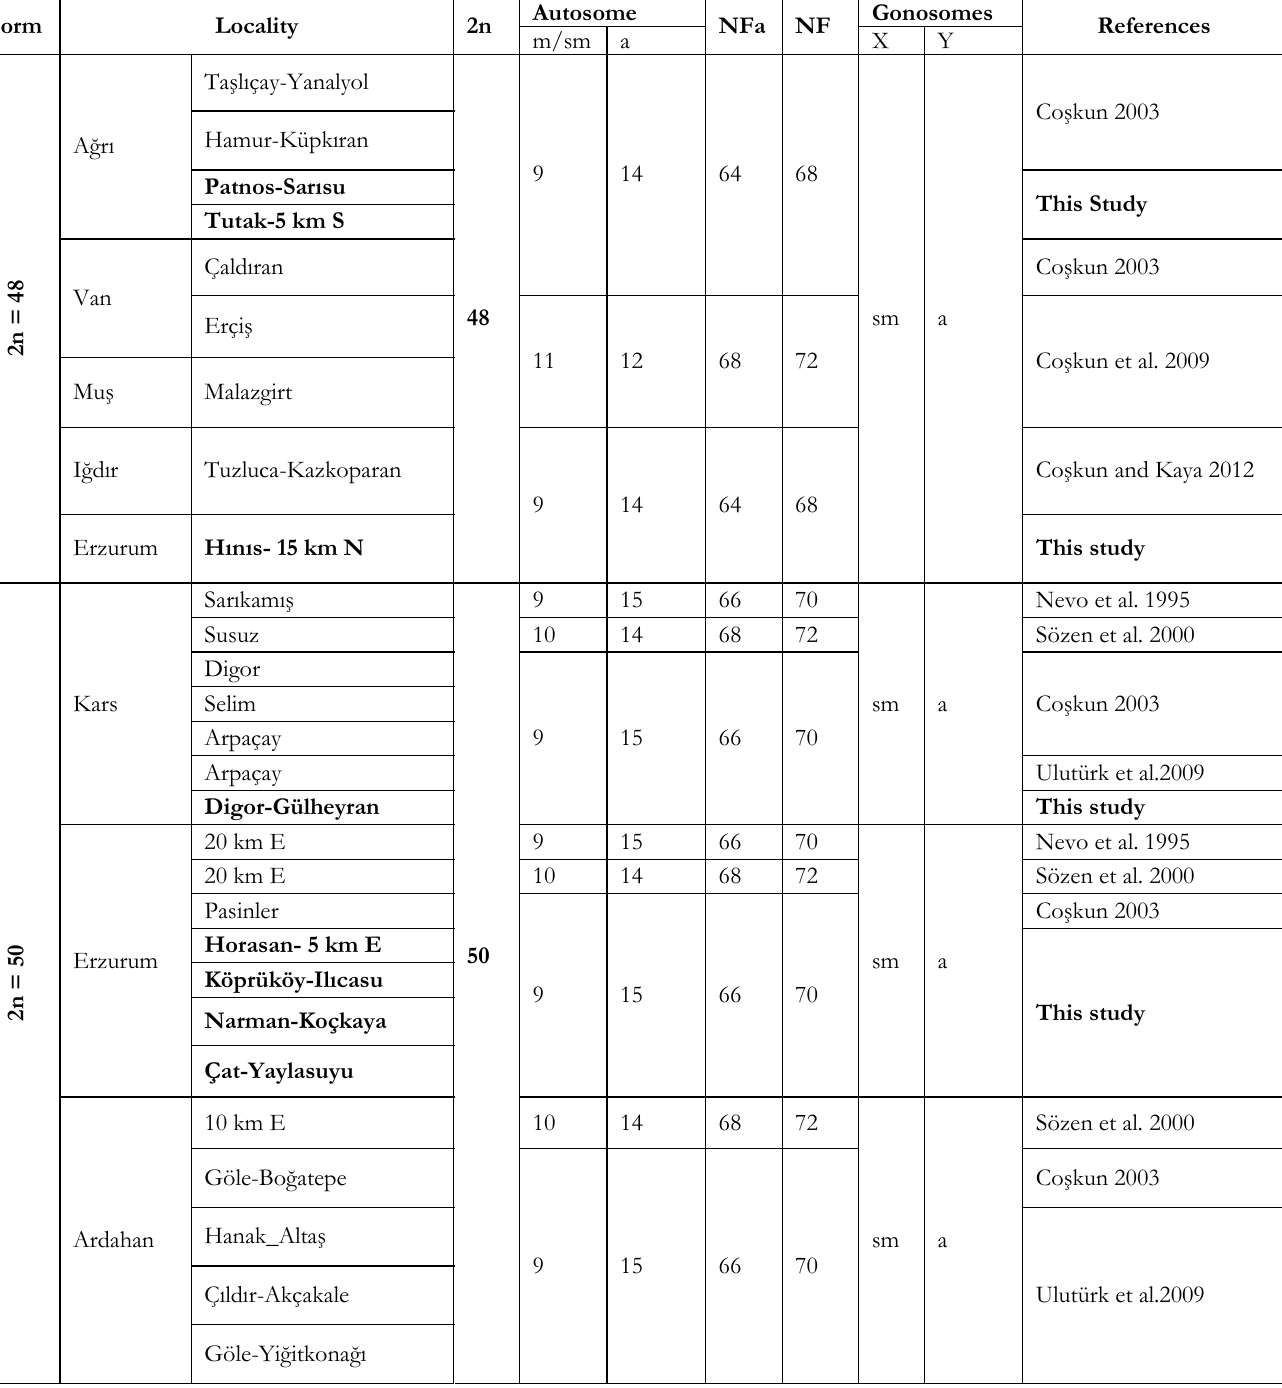
T ABLE 1. Chromosomal data for the genus Nannospalax from East Anatolia. 2 n : diploid number; m/sm: number of pairs of metacentric and submetacentric chromosomes; a/st: number of pairs of acrocentric and subtelocentric chromosomes; X: X chromosome, Y: Y chromosome, NF(a): (autosomal) fundamental number